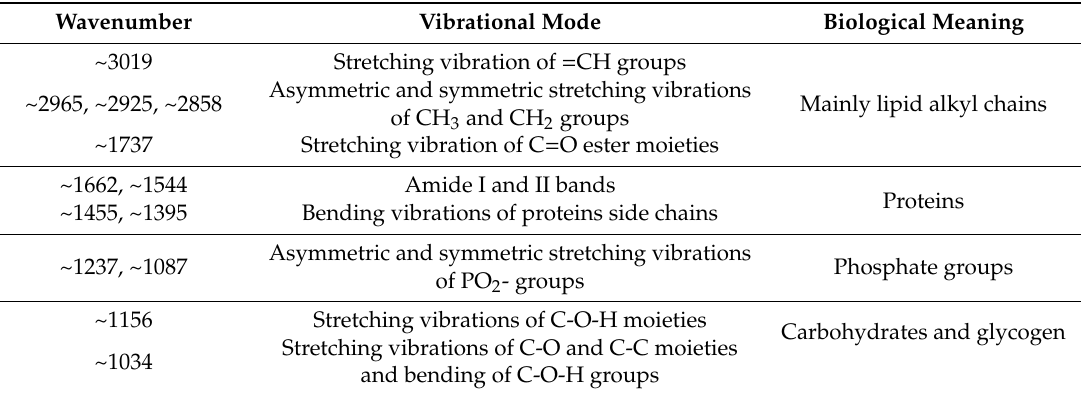
Table 5. Absorption bands detected on second derivative IR spectra of H0, H25 and H50 experimental groups. For each band, the wavenumber (expressed as cm − 1 ), together with the vibrational mode and the biological meaning are reported.